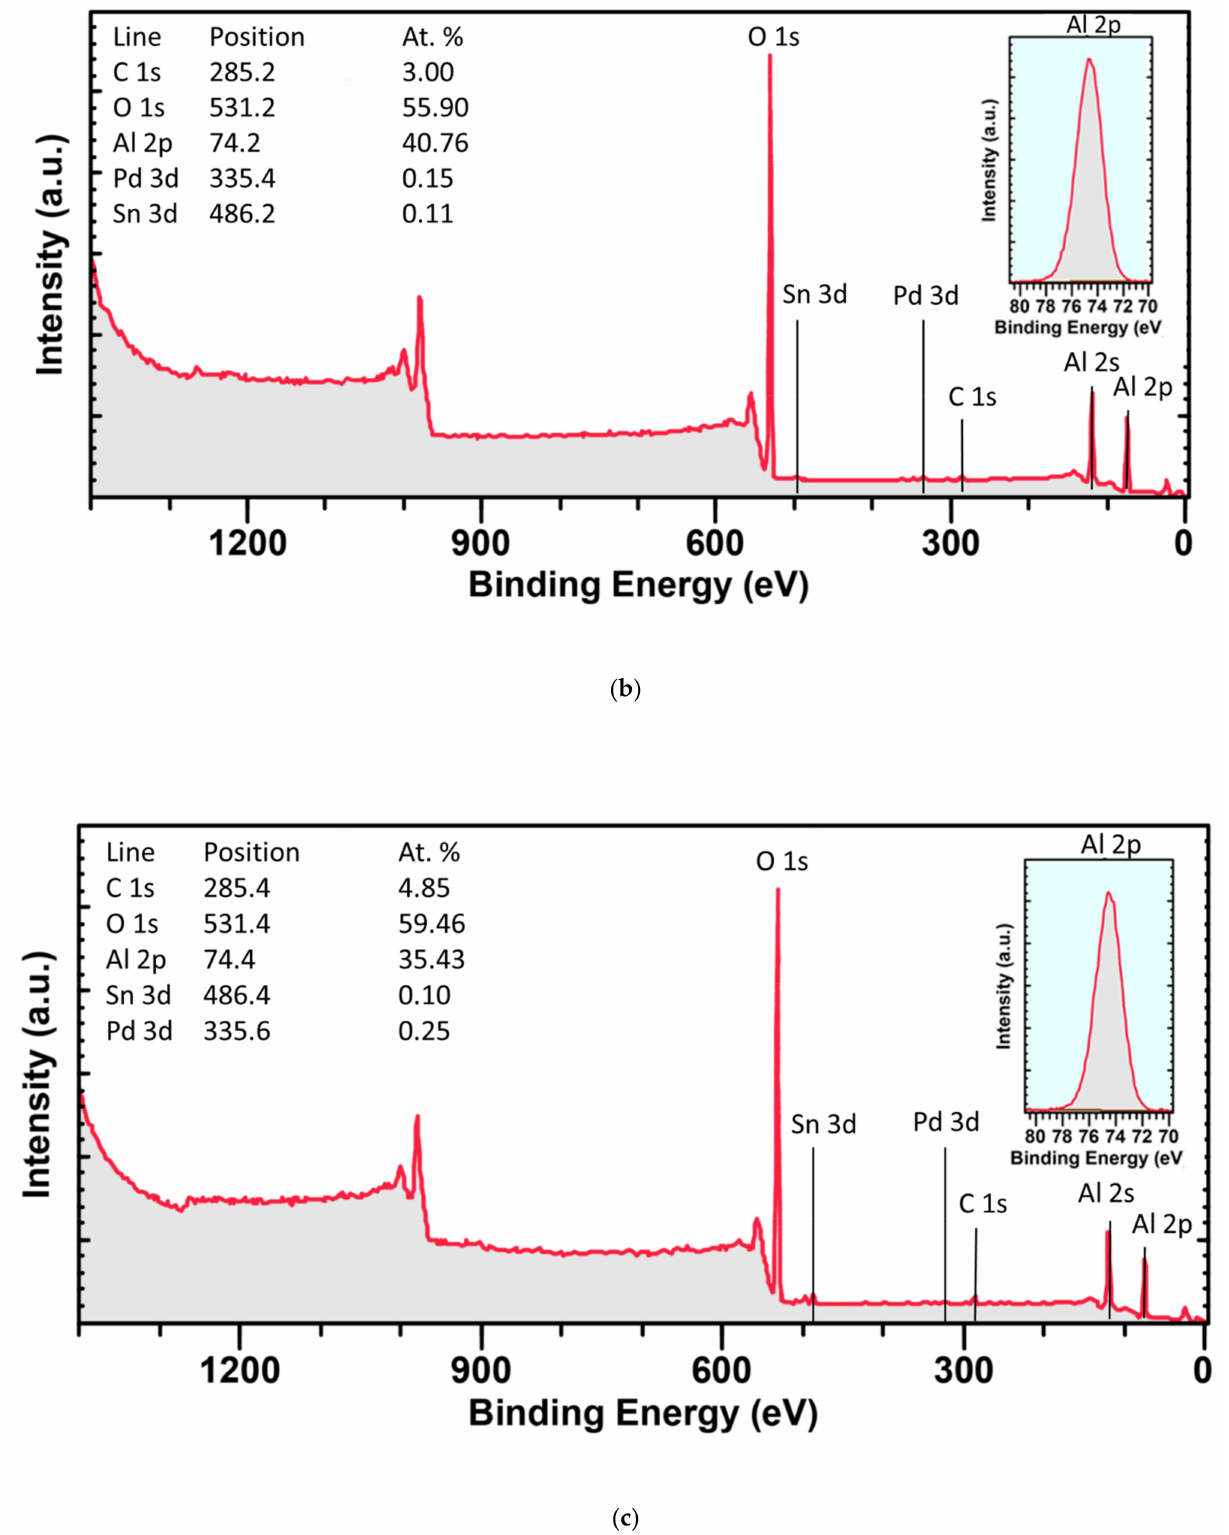
Figure 10. XPS survey spectra of the samples: ( a ) Pd/ γ -Al 2 O 3 . ( b ) 3Pd1Sn/ γ -Al 2 O 3 and ( c ) 1Pd1Sn/ γ -Al 2 O